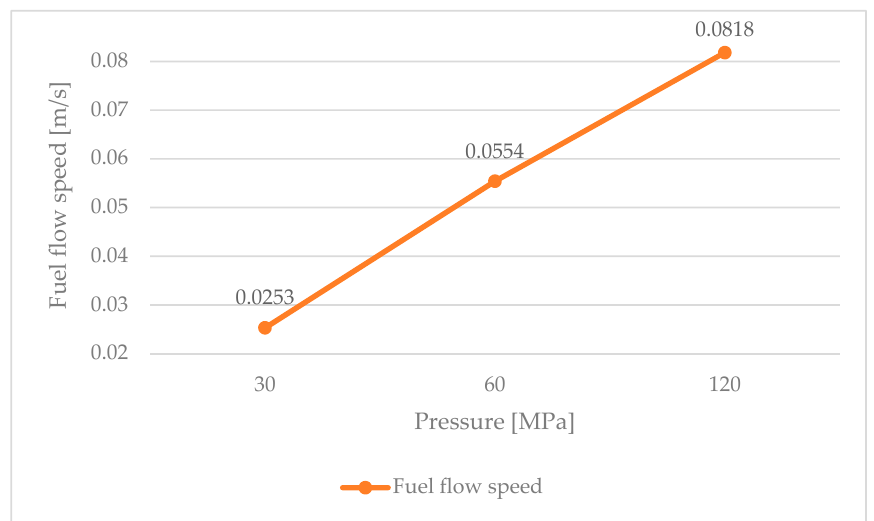
Figure 4. Fuel flow speed inside the injector nozzle depends on the system pressure [19].